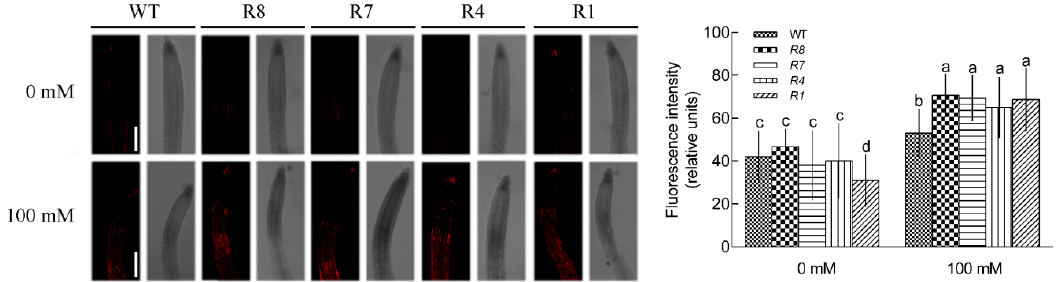
Figure 4. Ca 2+ levels within roots of GL1 and CPK12 -RNAi plants. ( A ) Seven-day-old seedlings were transferred to MS medium supplemented with (100 mM) or without NaCl (0 mM) for 12 h, then stained with the Ca 2+ -specific fluorescent probe Rhod-2 AM for 1 h at room temperature. Orange-red fluorescence within cells was detected at the apical region of roots under a Leica confocal microscope. Representative confocal images show cytosolic Ca 2+ content in plant roots. Scale bars, 100 μ m. ( B ) The relative fluorescence intensity (±SD) represents the mean of 10 independent seedlings. The mean values of Ca 2+ fluorescence are labeled with letters in the same group to denote significant differences ( p < 0.05).